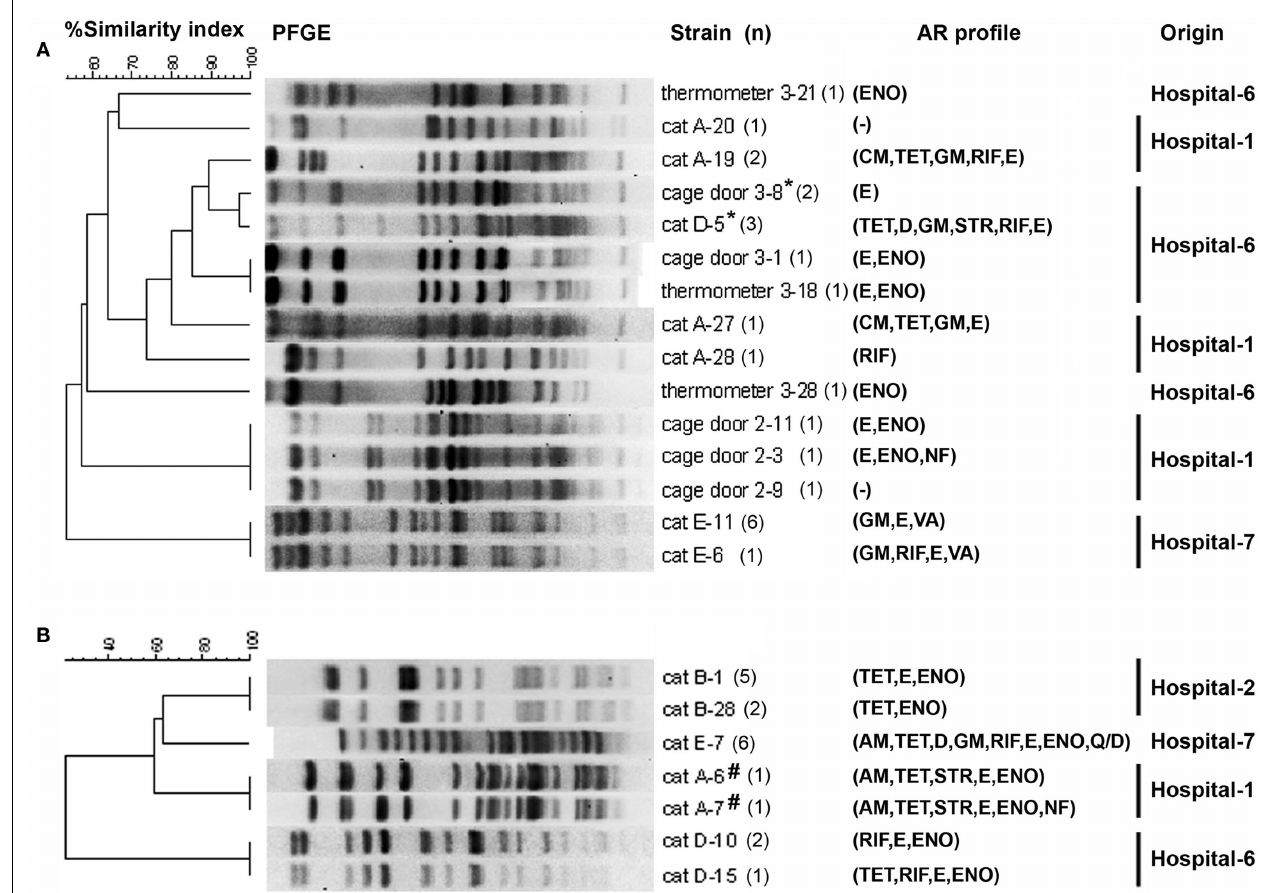
isolated from surface of a cage door and a stethoscope, and 96.9% similarity to E. faecium isolated from surface of a thermometer of the corresponding hospital (KuKanich et al., 2012); AM, ampicillin; CM, chloramphenicol;TET, tetracycline; D, doxycycline; GM, gentamicin; STR, streptomycin; RIF, rifampicin; E, erythromycin; ENO, enrofloxacin;VA, vancomycin; Q/D, quinupristin/dalfopristin; NF, nitrofurantoin. Hospital surface isolates were not screened for resistance to tetracycline, chloramphenicol, linezolid, streptomycin, and